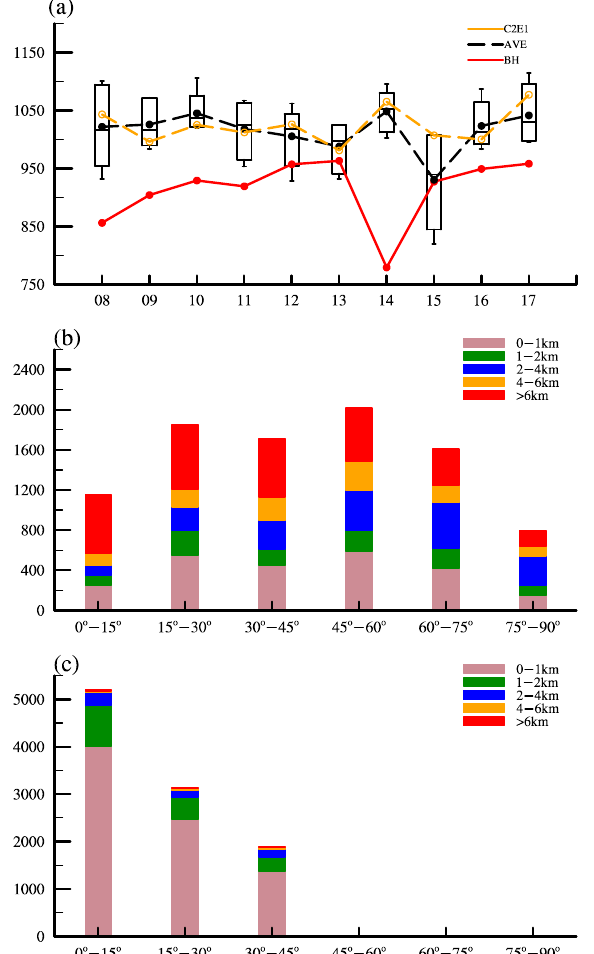
Figure 3. ( a ) Time series of the frequencies of the BH and C2E1 data; the frequencies of the ( b ) BH and ( c ) C2E1 data at different altitudes and latitudes.